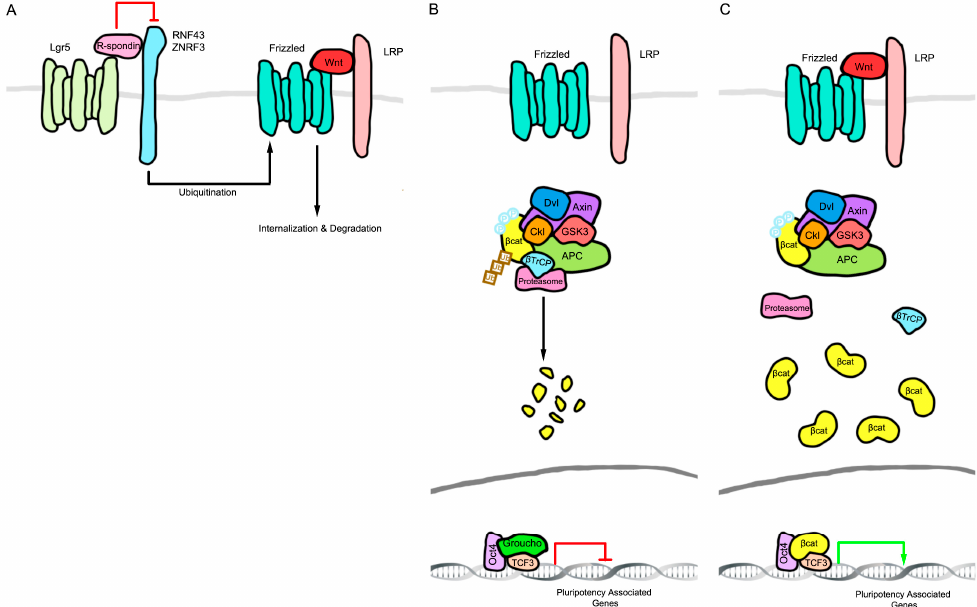
Figure 1. Schematic of the Wnt signaling pathway that determines stem cell self-renewal. ( A ) Leucine-rich repeat-containing G-protein coupled receptor 5 (LGR5) binds to R-spondin proteins, which in turn prevents the endocytosis of Wnt/Receptor complexes through ring finger 43 (RNF43)/E3 ubiquitin ligase zinc and ring finger 3 (ZNRF3)-mediated membrane clearance. This maintains the Wnt-bound receptor complex (Wnt/Frizzled/ LDL receptor related protein (LRP)) at the plasma membrane, nucleating activation complexes and inhibiting β -Catenin degradation enhancing Wnt signaling; ( B ) In the absence of Wnt protein, β -Catenin is degraded and transcription factor 3 (TCF3)-mediated repression of POU domain, class 5, transcription factor 1 ( OCT4 ), sex determining region Y ( SRY ) transcription factor SOX-2 ( SOX2 ), and Nanog homeobox ( NANOG ) target genes prevents self-renewal. ( C ) Stabilized β -Catenin upon the activation of Wnt signaling suppresses TCF3-mediated repression of OCT4 , SOX2 , and NANOG target genes to mediate signaling for self-renewal. Dvl: Dishevelled; APC: Adenomatosis polyposis coli; Ckl: Casein kinase 1; β Cat: β -Catenin; β TrCP: β -transducin repeat containing E3 ubiquitin protein ligase; Ub: Ubiquitination